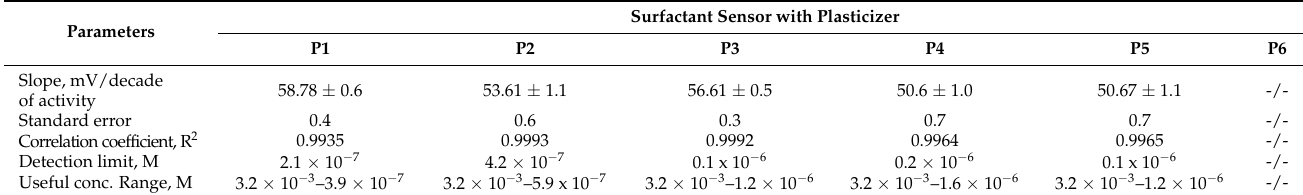
Table 2. Statistics of the response characteristics of the P1–P6 surfactant sensors to Hyamine, given together with ± 95% confidence